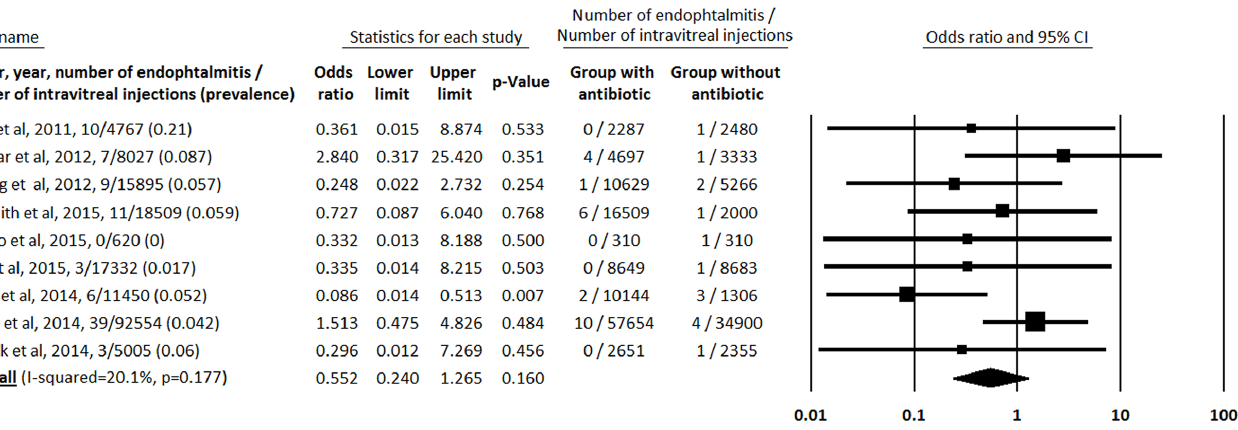
Fig 3. Odd ratio for each study including only culture-proven